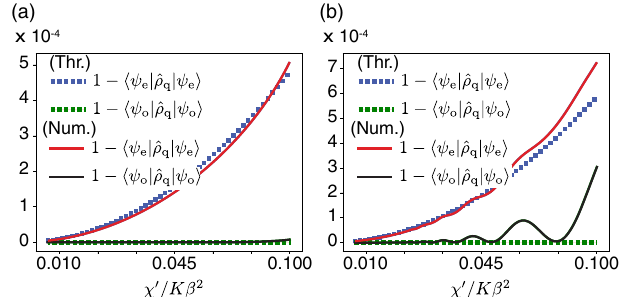
FIG. 16. Dependence of phase diffusion in the state of the qubits as a function of the coupling strength. In (a), the time dependence of the interaction between the qubits and PCO is ffiffiffi p π taken as Gaussian χ ð t Þ ¼ ð χ 0 = Þ exp ð − t 2 =T 2 z Þ with cutoffs at (cid:3) 3 T z . In (b), the time dependence of the interaction between the qubits and PCO is χ ð t Þ ¼ 0 . 5 χ 0 π sin ð π t=T with cutoffs at 0 and ffiffiffi z Þ p π T . χ 0 is the peak interaction strength so that in (a) χ 0 ¼ χ 0 z and in (b) χ 0 ¼ πχ 0 = 2 . The parameters are P ¼ 4 K ( β ¼ 2 ) and π = 8 χ β . The phase diffusion is suppressed when the T 0 z ¼ excitations out of the C subspace are negligible, that is, when χ = 0 K β 2 is small. Both theoretical (dotted lines) and numerical (solid lines) results are shown. The agreement between the two is good for small χ 0 . As χ increases, the first-order perturbation theory is not sufficient, and the effect of other states in the PCO must be included. Also in (b), the effect of nonadiabatic terms and higher-order effects becomes apparent at smaller χ 0 compared to (a). For small χ 0 , the average phase diffusion decreases quad- ratically with χ 0 =K β 2 . For example, the phase diffusion is < 10 − 4 when χ 0 =K β 2 < 0 . 045